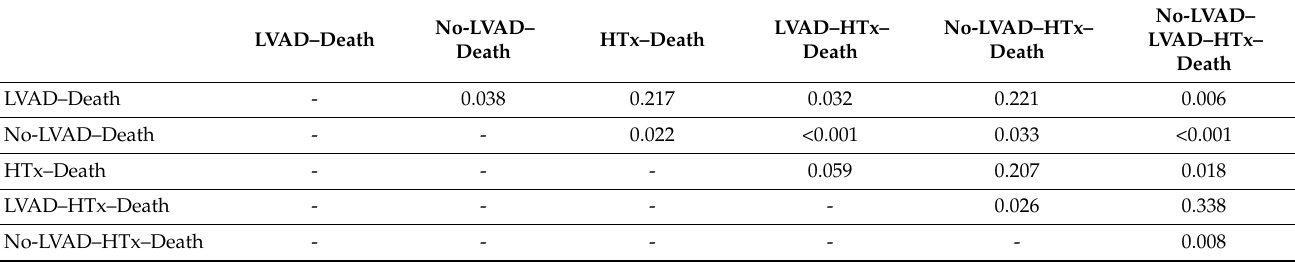
Figure 2. Multi-state model for survival analysis with transition probability (and 95% confidence interval) matrix and curves of death probabilities by treatment. Table 4. p values for comparison among transition probabilities in the multi-state model.